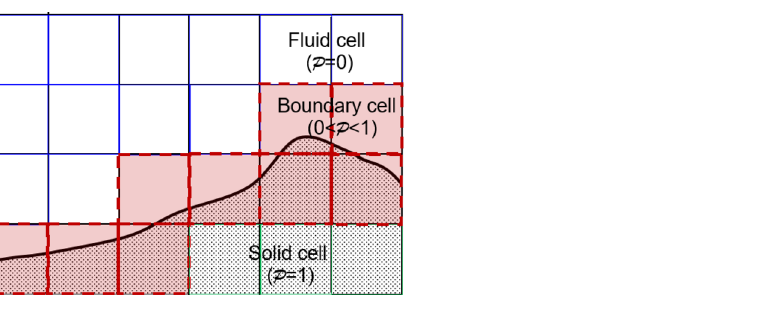
1 , green), fluid ( P 0 , white), and = =